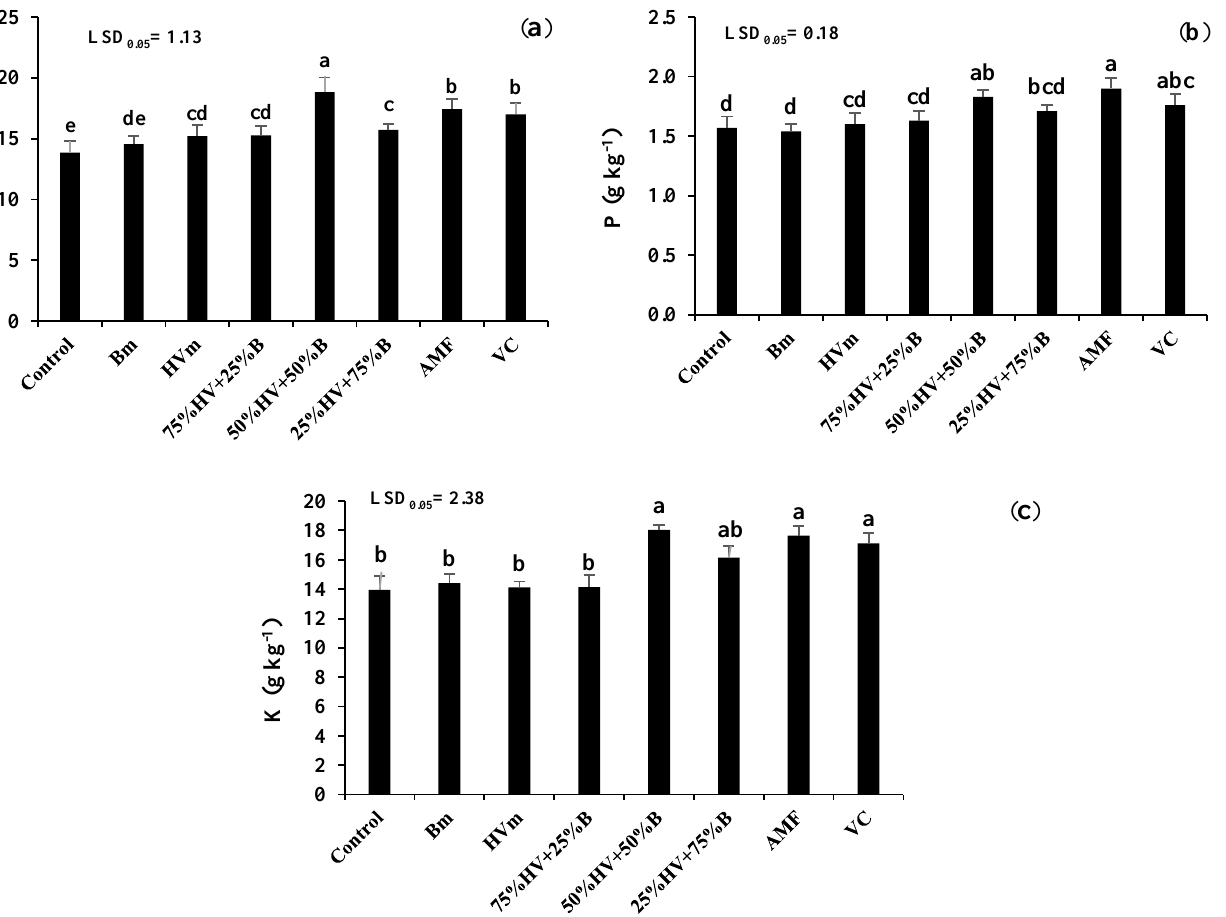
Figure 2. The content of N ( a ), P ( b ) and K ( c ) of peppermint in different fertilizer sources. Bm (Barley monoculture); HVm (hairy vetch monoculture); 50%HV + 50%B, 75%HV + 25%B and 25%HV + 75%B (different intercrop ratios of hairy vetch/barley); AMF (arbuscular mycorrhizal fungi); VC (vermi- compost). Similar letters above the bars do not differ significantly ( p < 0.05) according to LSD test. Table 1. The agronomic characteristics, leaf greenness, dry yield, essential oil content and essential oil yield of peppermint under different fertilizer sources (Average of two